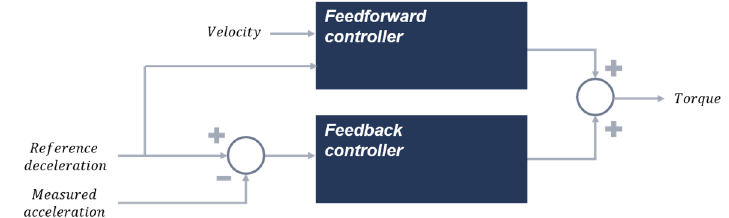
Figure 13. Acceleration controller.